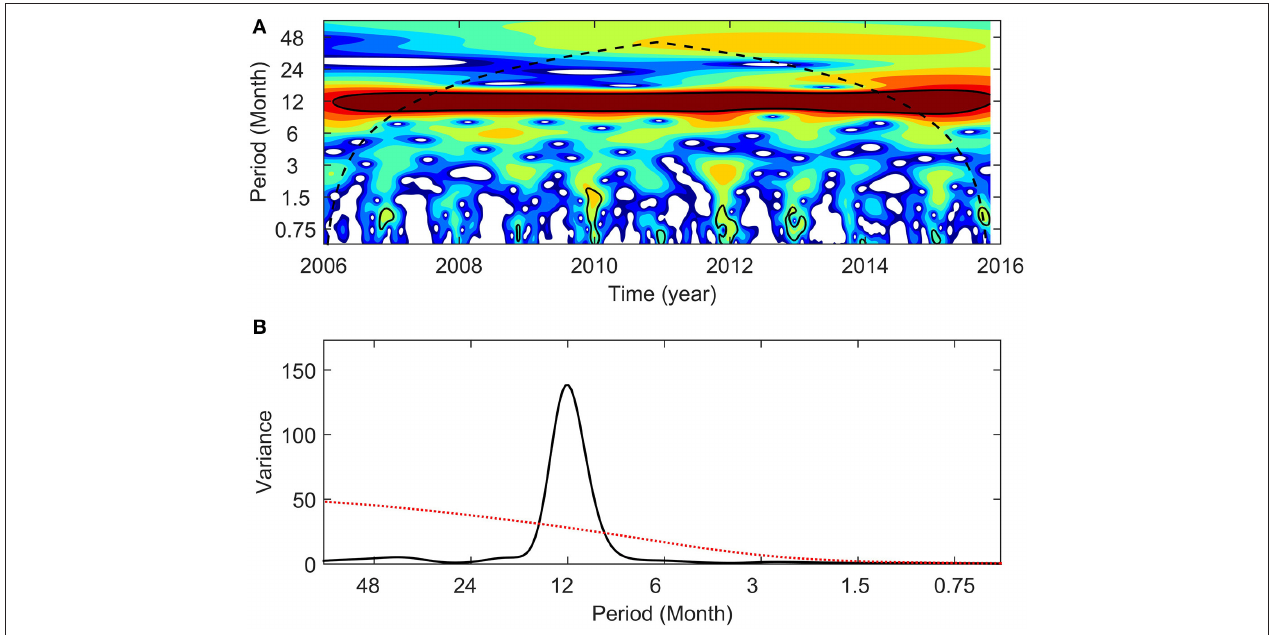
FIGURE 8 | Satellite Net Primary Production estimations wavelet power spectrum (A) and normalized global wavelet spectrum (B) with 95% confidence interval (black contours and red line, respectively). In wavelet power spectra the color scale indicates the strength of the periodicities over time (blue: weak variance; red: strong variance); the black dashed line represents the cone of